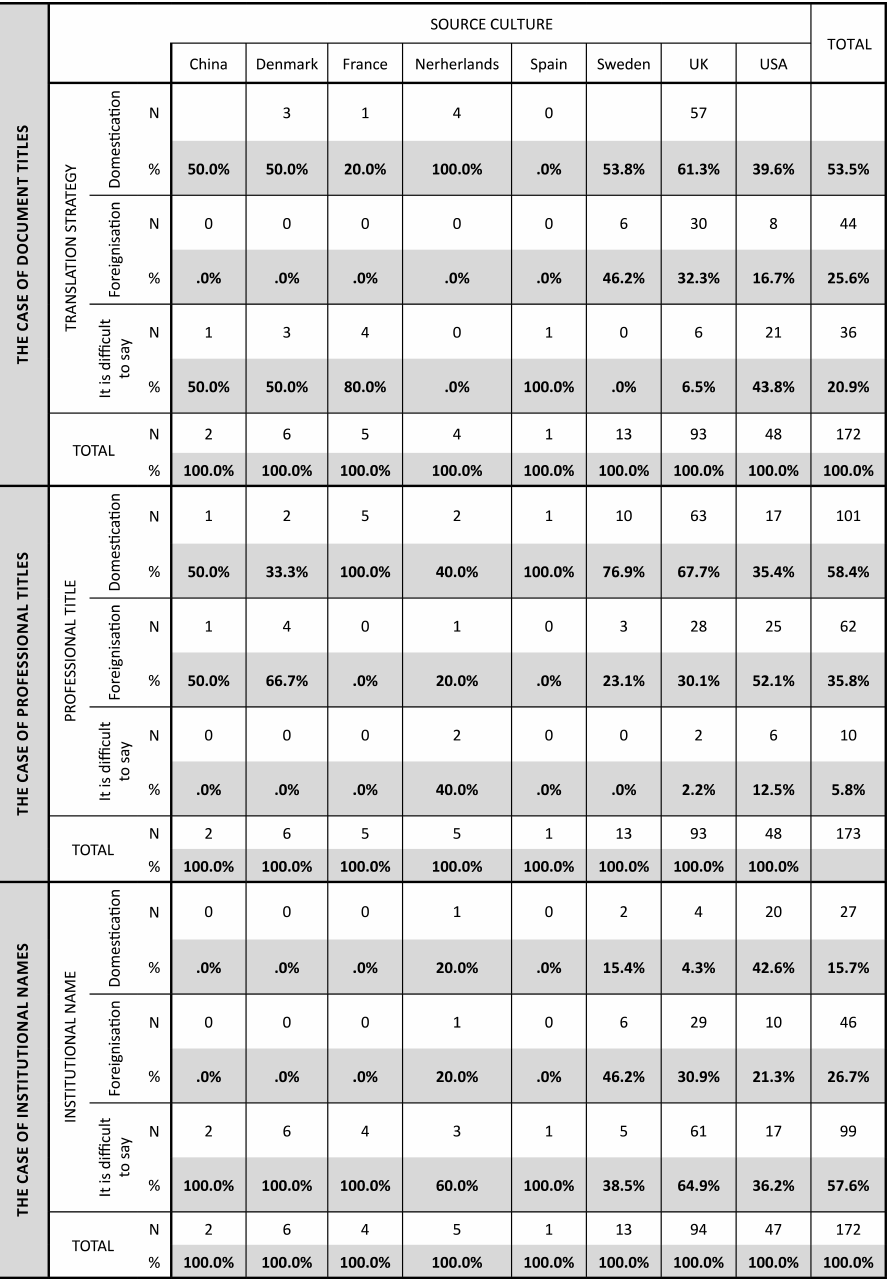
Cross tabulation between strategy and source